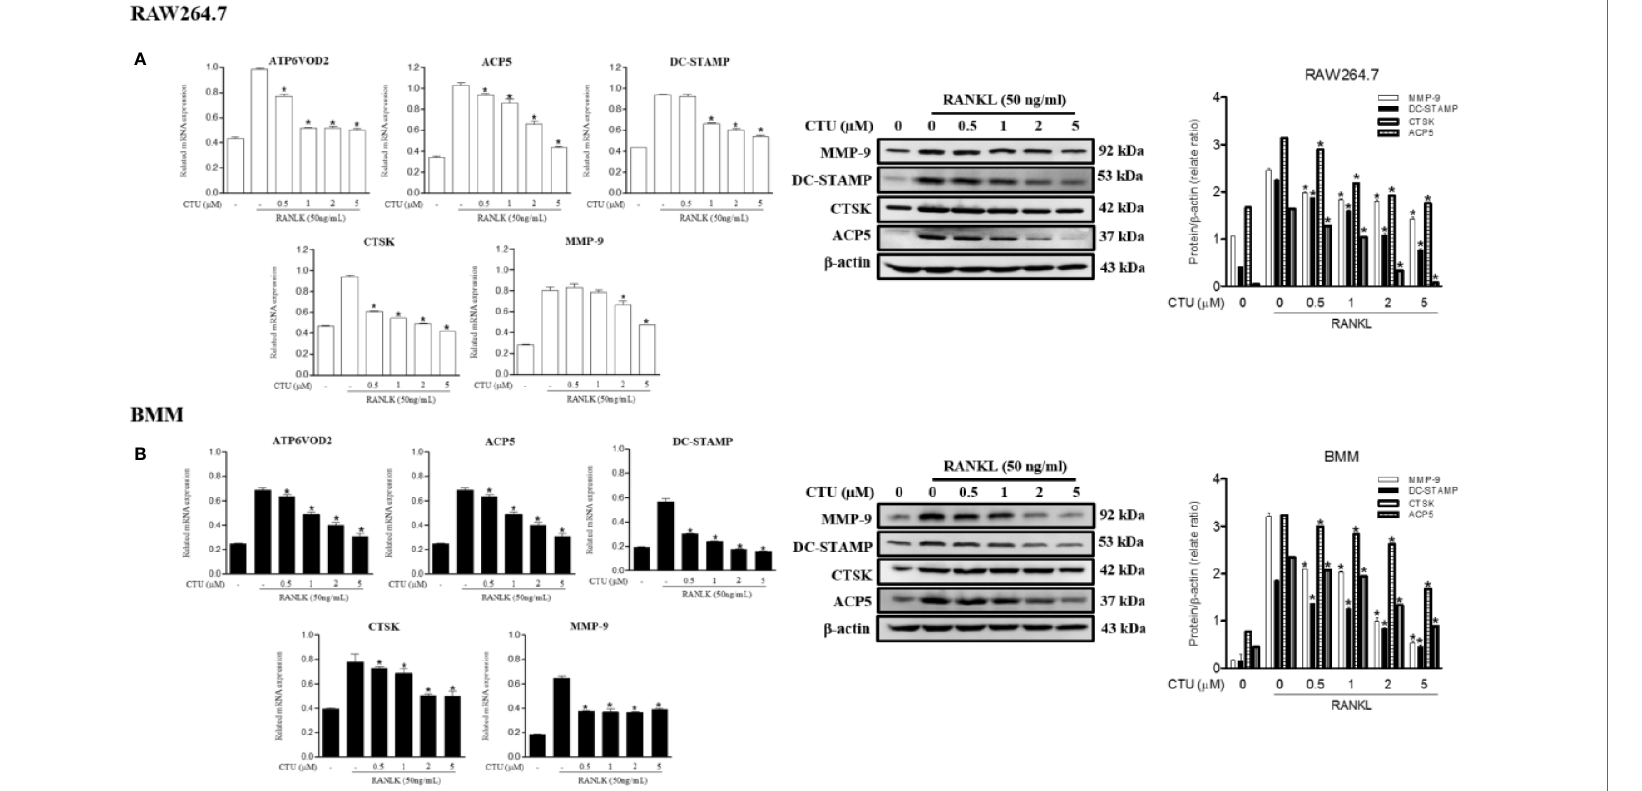
FIGURE 6 | The effect of CTU on osteoclast-speci fi c gene and protein expression in RANKL-induced RAW 264.7 (A) and BMM (B) cells. The cells were treated with different concentrations of CTU in the presence of RANKL, and osteoclast-speci fi c gene expression was measured by real-time PCR. The results were normalized to GAPDH expression. * p < 0.05 compared with only RANKL-treated